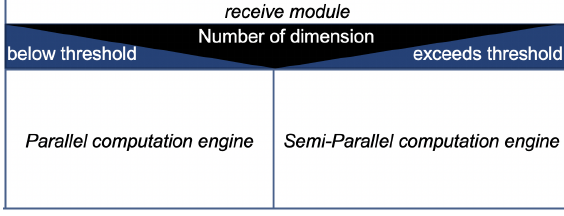
Figure 1. Which computation engine is used depends on